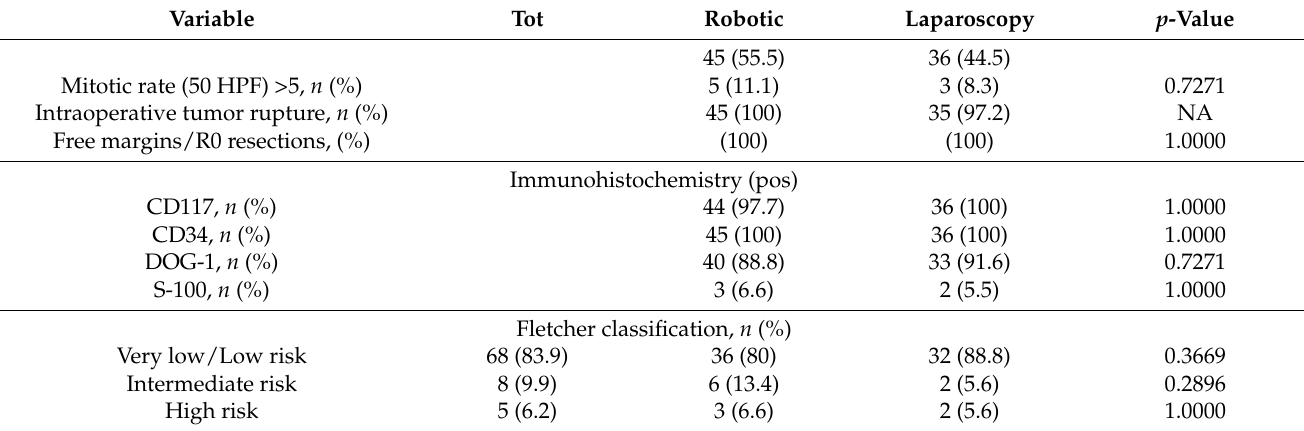
Table 1. Pathologic features.